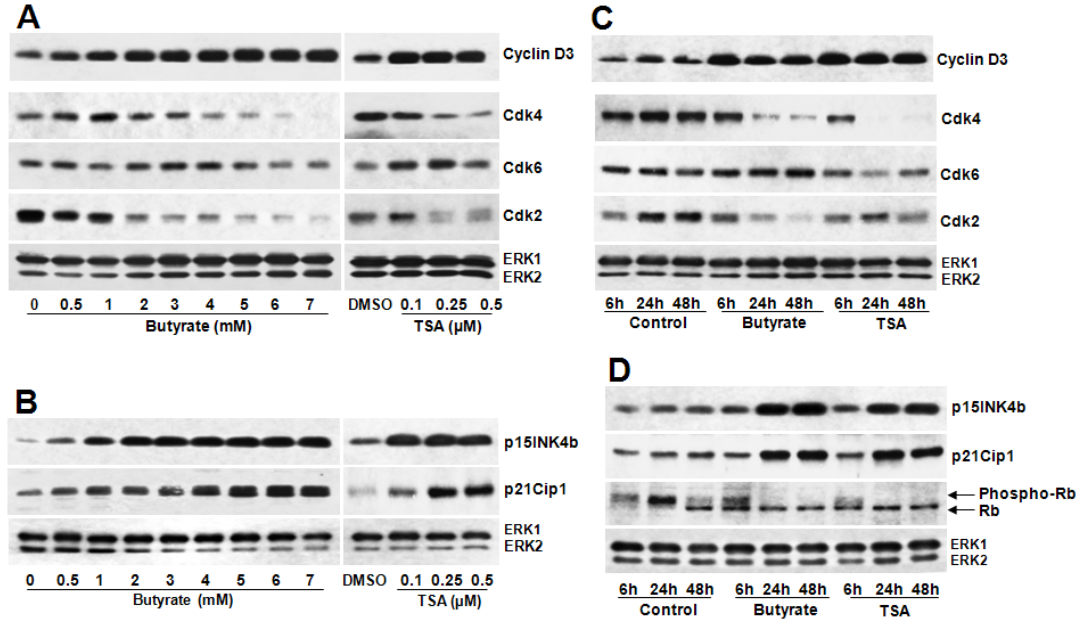
Figure 2. Comparison of butyrate and TSA effects on G1-specific cell cycle regulatory proteins. Proliferating VSMC were treated with different concentration of butyrate or TSA for 48 h ( A and B ) or treated with butyrate or TSA for indicated periods of time ( C and D ) to determine dose- and time-dependent effects of butyrate and TSA on G1-specific cell cycle proteins, respectively. At the end of treatment, cell lysates were prepared and processed for western analysis of cyclin D3, cdk4, cdk6, cdk2, p15INK4b, p21Cip1, Rb and phospho-Rb. Immunoblotting of ERK1/2 was performed with the same lysate to normalize the protein loading. Results shown are the representative of three independent experiments. The density of each band is measured and normalized to protein loading. The data obtained are analyzed and expressed as mean ± S.D. Expression of cyclin D3 ( A ), p21Cip1 and p15INK4b ( B ) are increased very significantly by I mM to 7 mM butyrate concentration vs. control ( p < 0.001) and by 0.1 µM to 0.5 µM TSA concentration vs. DMSO ( p < 0.001). Expression of cdk4 and cdk2 ( A ) are significantly decreased by 2 mM to 7 mM butyrate vs. control ( p < 0.01) and by 0.25 µM to 0.5 µM TSA vs. DMSO ( p < 0.01). Cdk6 is marginally affected by butyrate and TSA compared to their respective controls ( A ). Cyclin D3 ( C ), p21Cip1 and p15INK4b ( D ) are significantly increased both by 5 mM butyrate and 0.5 µM TSA vs. control ( p < 0.001) at all experimental periods of time. Cdk4 and cdk2 are decreased by butyrate significantly after 6 h of treatment ( p < 0.001) but no significant change in cdk6 vs. control ( C ). TSA causes significant reduction of cdk4 after 6 h ( p < 0.001), cdk2 after 24 h ( p < 0.05) and no significant effect on cdk6 ( C ) compared to control. Phosphorylation of Rb protein ( D ) is significantly inhibited both by butyrate and TSA after 6 h treatment compared to control ( p <